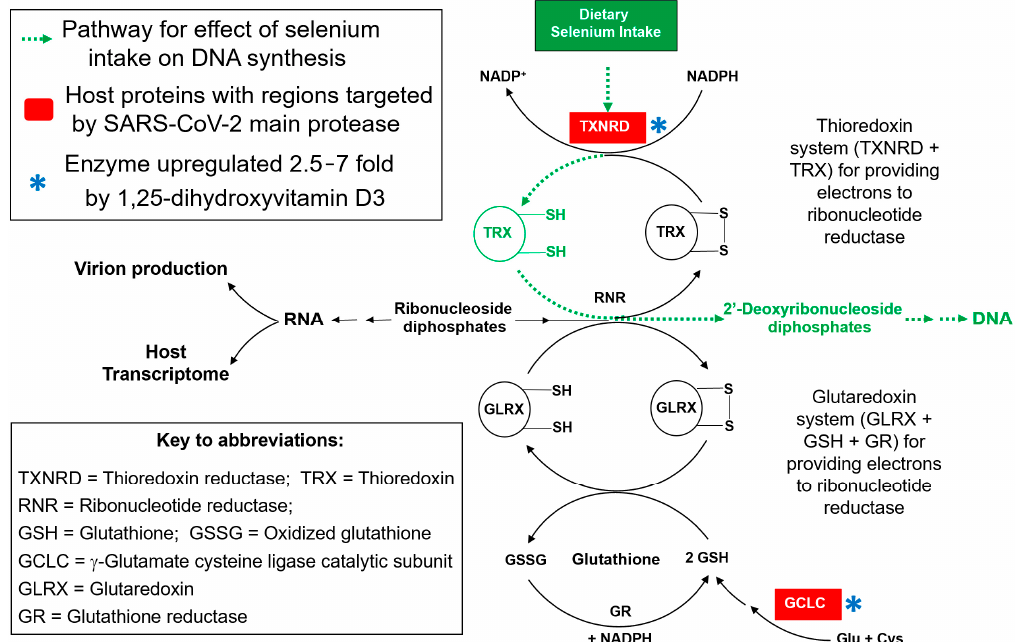
Figure 8. The synthesis of DNA from RNA precursors (ribonucleotides, as ribonucleoside diphos- phates, center) depends upon their reduction by RNR to produce 2 ′ -deoxyribonucleotides. Electrons for reduction by RNR come from either TRX or GLRX, the reduced forms of which must be con- stantly regenerated by one of the two essential redox cycles that sustain DNA synthesis: the TRX and GLRX systems. The former requires the selenoprotein TXNRD1, and the latter, GSH, a product of GCLC. Both TXNRD1 and GCLC are targeted by M pro , consistent with a viral strategy to inhibit DNA synthesis, to conserve the pool of ribonucleotides for increased virion production [33]. Signif- icantly, in an opposing action, both of these targets are also upregulated at the mRNA level by 1,25- dihydroxyvitamin D3, which may contribute to the reported benefits of vitamin D in COVID-19 [5,6,57].